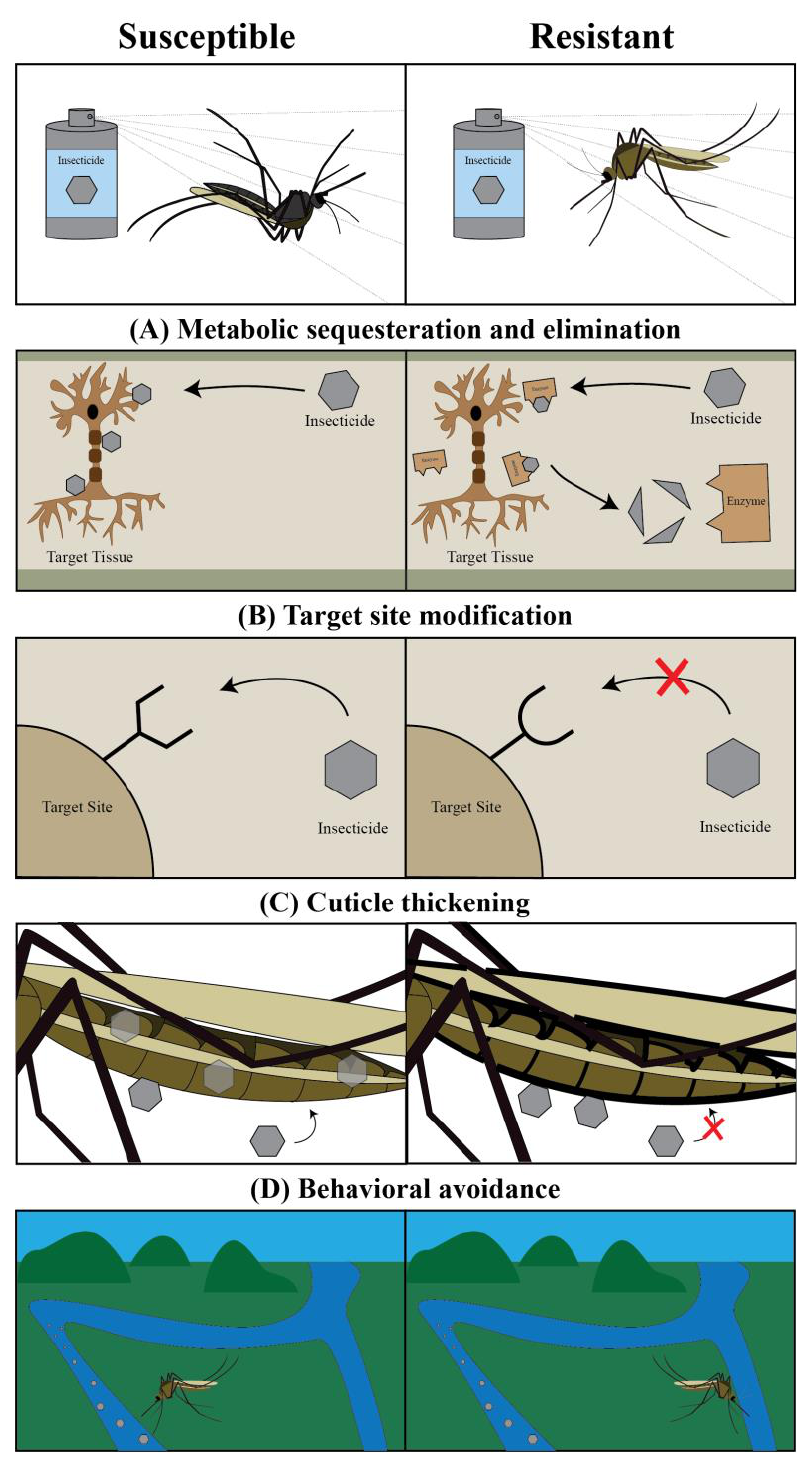
Figure 2. Insects utilize four primary strategies to evolve resistance against insecticides: metabolic sequestration and elimination, target site modification, cuticle thickening, and behavioral avoidance. ( A ) Metabolic sequestration and elimination results from the upregulation of enzymes that intercept and degrade the insecticide before it reaches the target site. ( B ) Target site modification results from the changing of a target site such that it cannot interact with the insecticide. ( C ) Cuticle thickening results from an increase in cuticular thickness and a decrease in cuticular permeability, thereby preventing an insecticide from entering the body. ( D ) Behavioral avoidance results from the changing of behavior such that the insect avoids encountering an insecticide.